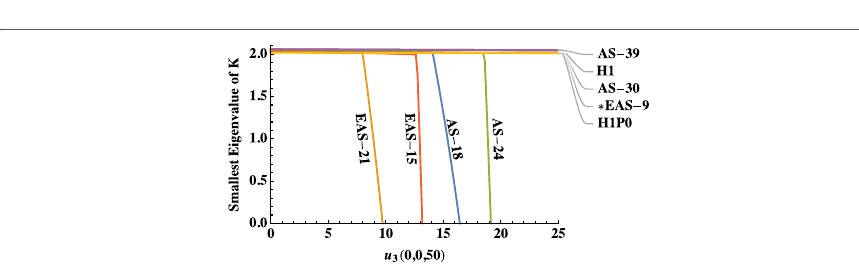
Fig. 13 Hourglassing test: geometry, representative mesh, deformed configuration and the boundary conditions